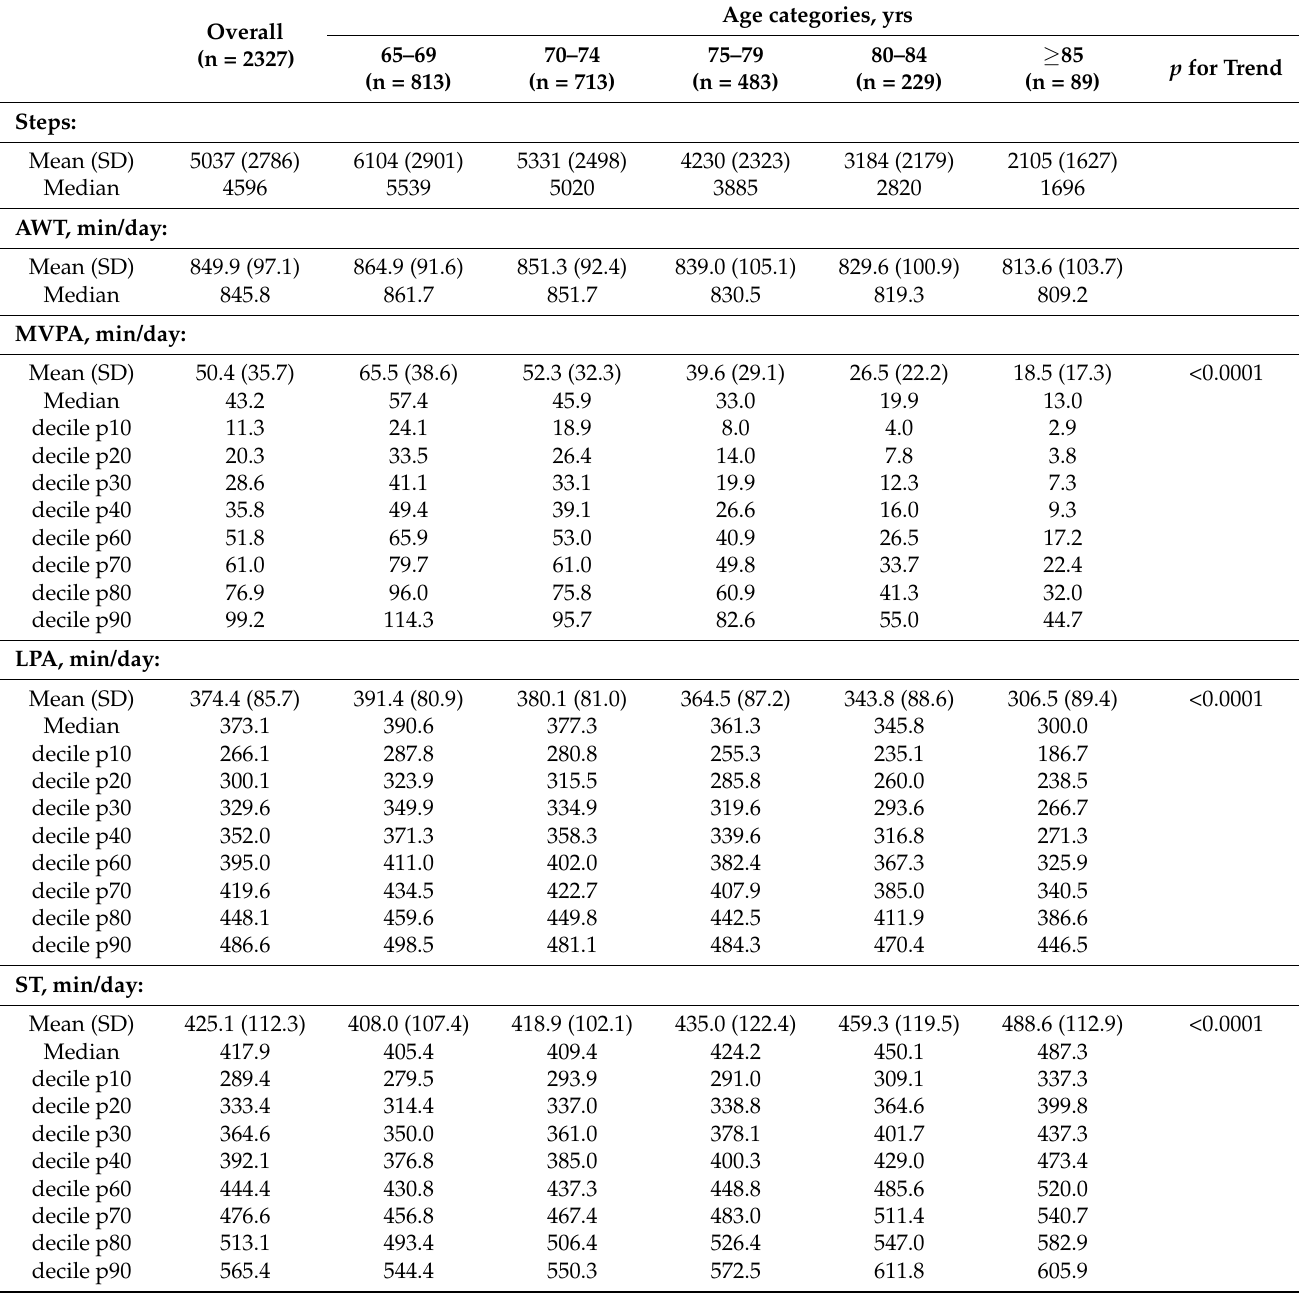
Table 2. Tri-axial accelerometer-determined PA and ST by age groups in the women (n =